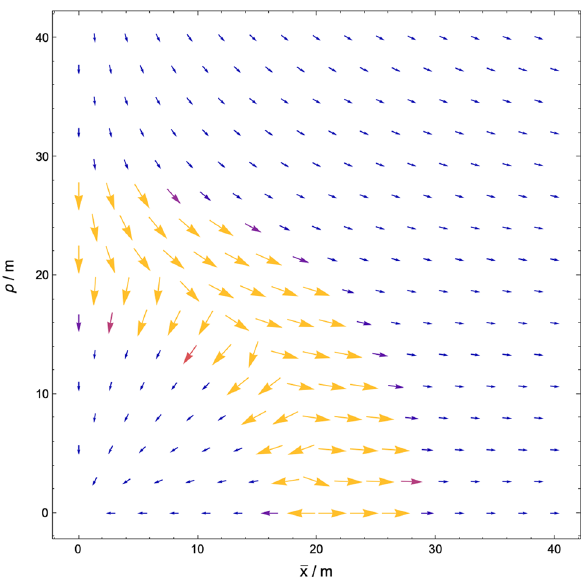
Fig. 2 Vectorplotofthedistortionforceforawarpbubblewithparam- eters σ = 1, R = 20 m , v s = 2